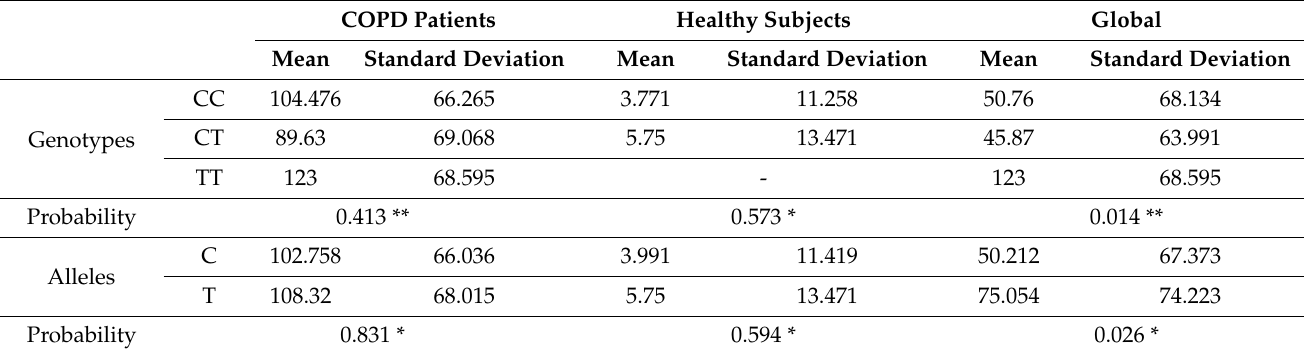
Table 4. Analysis of the VEGF serum levels by genotypes and alleles.